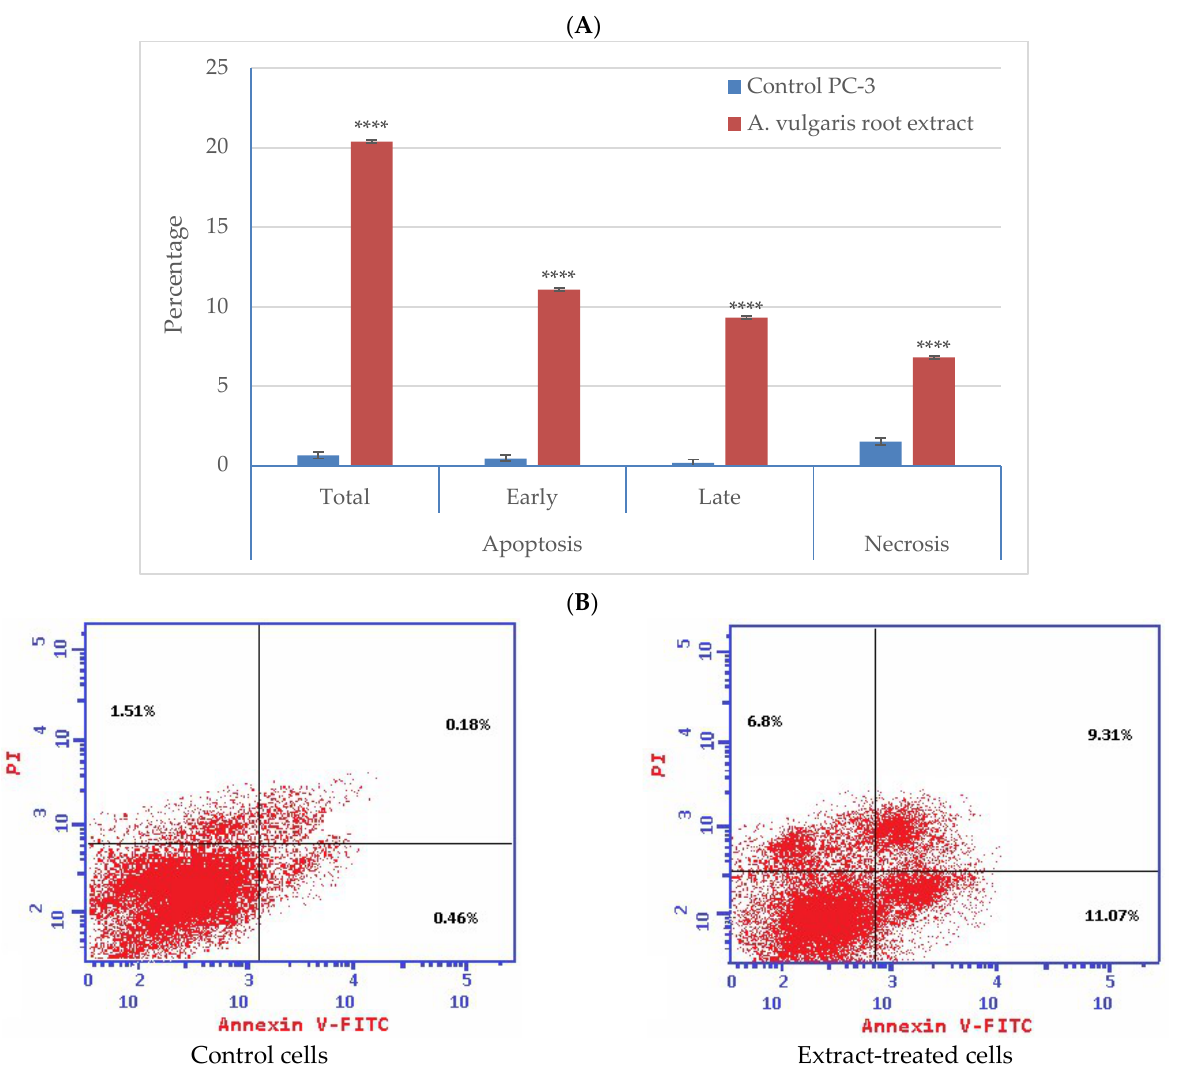
Figure 5. Apoptotic effect of A. vulgaris root extract at 88.0 µg/mL on PC-3 cells: ( A ) percentages of the total, early and late apoptotic and necrotic cells in extract-treated PC-3 cells compared with the control cells; ( B ) flow cytometry dot plots of extract-treated cells showing necrotic cells (upper left quadrant), late apoptotic cells (upper right quadrant), viable cells (lower left quadrant) and early apoptotic cells (lower right quadrant). Significance differences between treated and control cells were determined using unpaired t -test, **** p < 0.0001. The data presented are the means ( n = 3) ± SD indicated by the vertical bars.